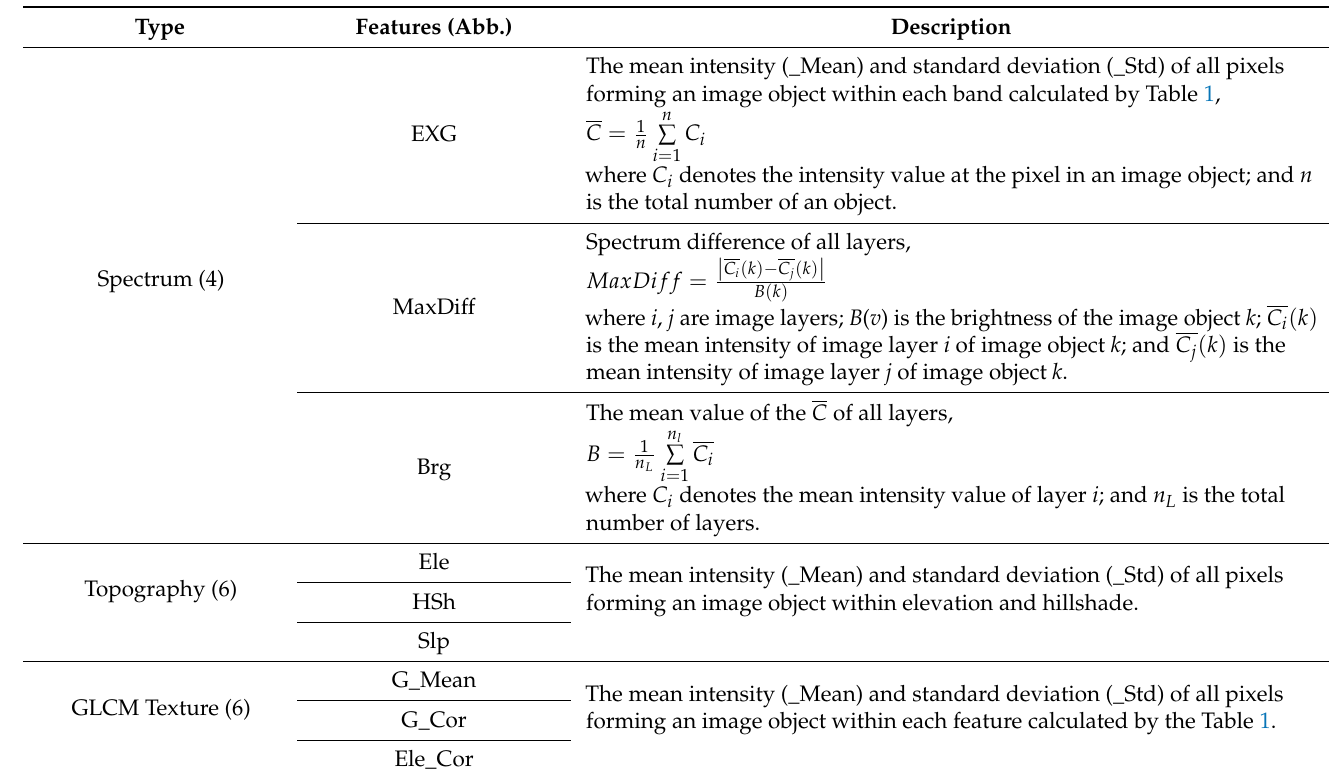
Table 2. Overview of the features used for terrace damages classification. Type Features (Abb.)